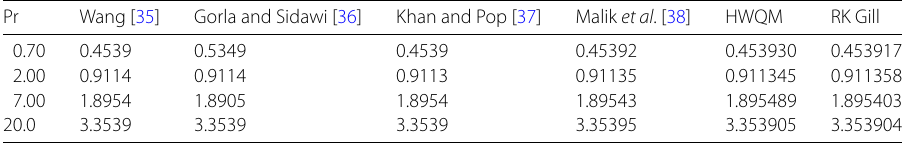
Table 1 Comparison of local Nusselt number – θ (cid:5) (0) in the case of Newtonian fluid ( β = γ = b = f w = 0) for different values of Pr Pr Wang [35] Gorla and Sidawi [36] Khan and Pop [37] Malik etal . [38] HWQM RK Gill 0.70 0.4539 0.5349 0.4539 0.45392 0.453930 0.453917 2.00 0.9114 0.9114 0.9113